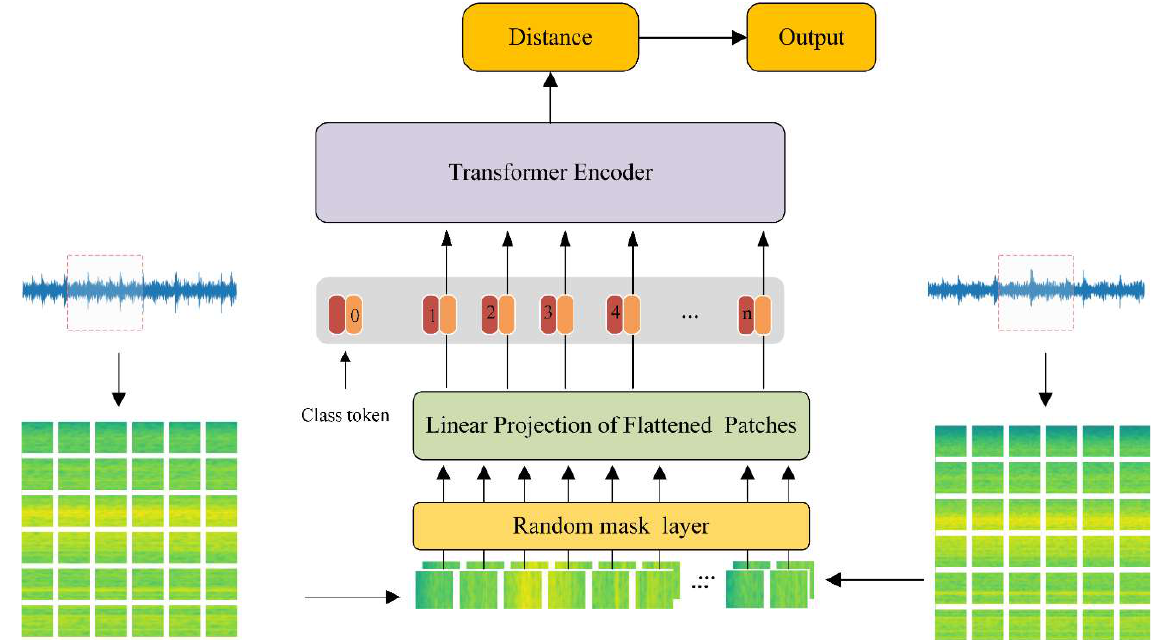
Figure 1. The overall framework of the proposed method.